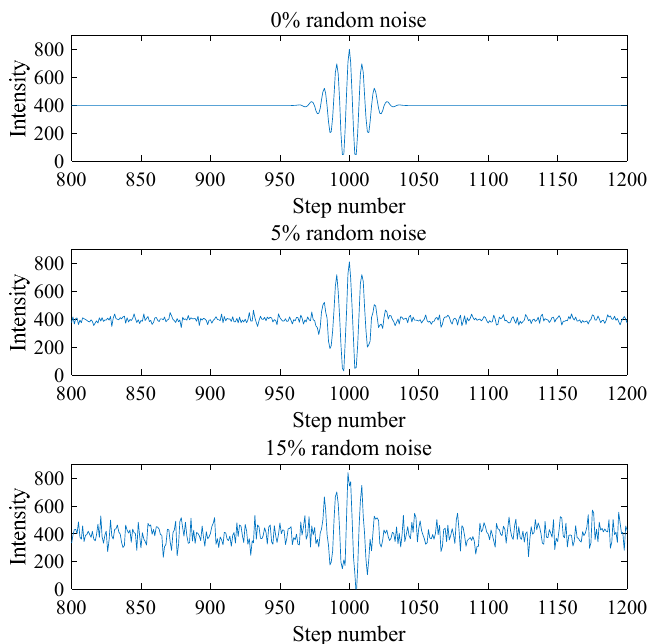
Figure 3. Simulated white light interferometric signals under different noise levels.